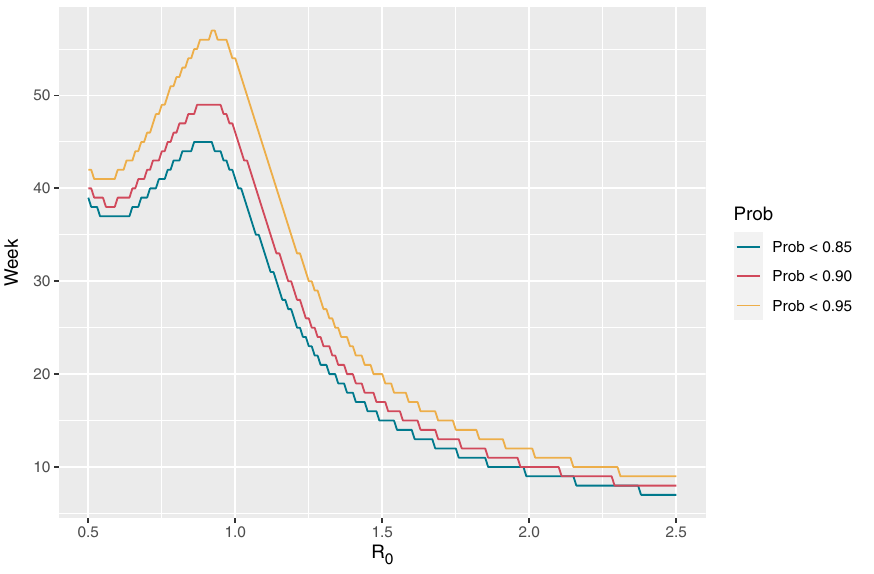
Figure 2. Weeks to extinction as function of the reproduction rate, R 0